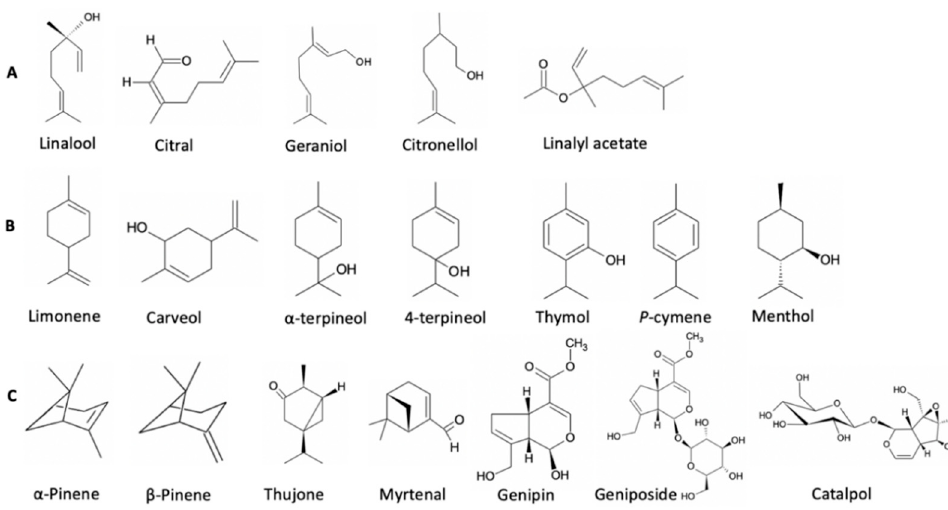
Figure 3. ( A ) Acyclic monoterpenes, ( B ) monocyclic monoterpenes, ( C ) bicyclic monoterpenes.